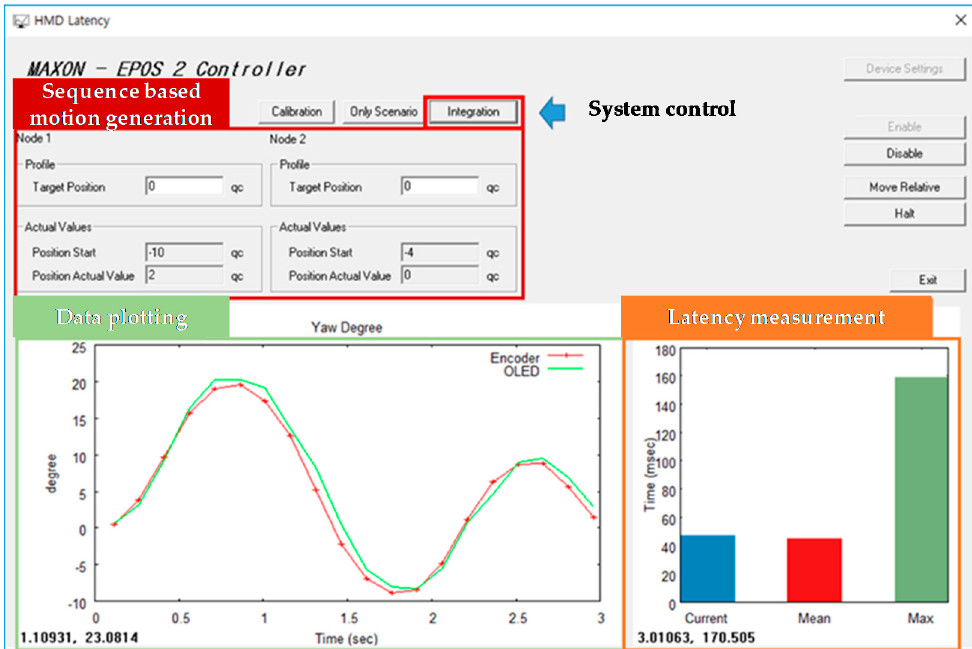
Figure 9. Proposed user interface of the motion-to-photon latency measurement system.